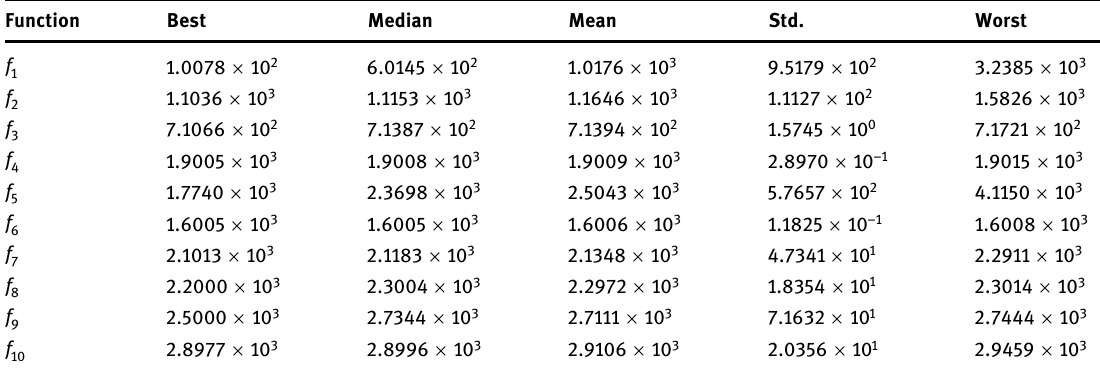
Table 3: The CEC 2020 ( = D 10 ) function values achieved by Jaya2 over 30 runs and 100,000 function evaluations Function Best Median